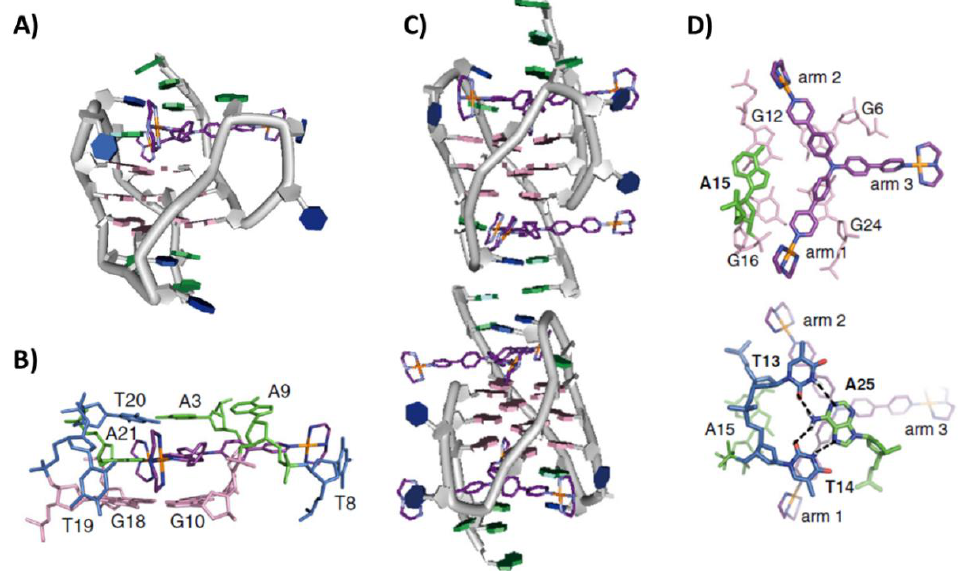
Figure 3. NMR structure of the complex between the unimolecular hybrid-1 h-tel26 G-quadruplex of sequence d[AAAGGG(TTAGGG) 3 AA] and Pt(II)-based tripod at ( A ) 1:1 or ( C ) 2:4 G-quadruplex/ligand stoichiometry. In ( A ), the 5′ - and 3′ -end of the G-quadruplex are at the top and bottom, respectively, while, in ( C ), G- quadruplex units are 3′ - 3′ stacked. Details of the ligand binding are highlighted in ( B ) for 1:1 and ( D ) for 2:4 G-quadruplex/ligand complexes. Adapted with permission from ref. [40], Copyright 2018 The Author(s).